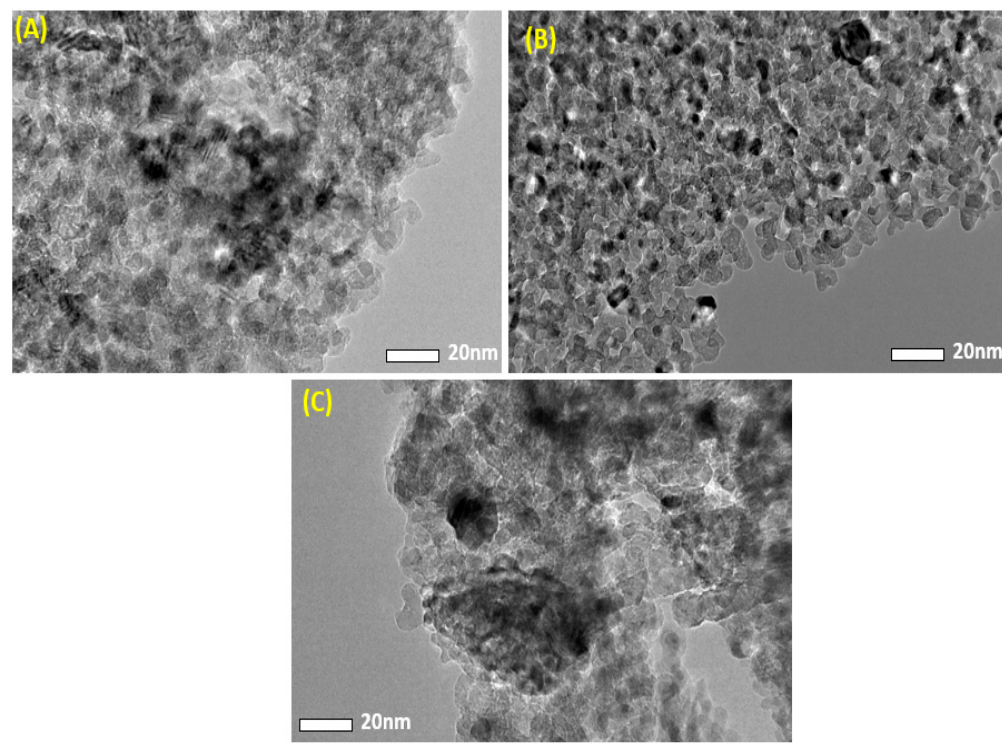
Figure 2. TEM images of pure MgO ( A ), 1% Ag ‐ MgO NPs ( B ), and 7.5%Ag ‐ MgO NPs ( C ).